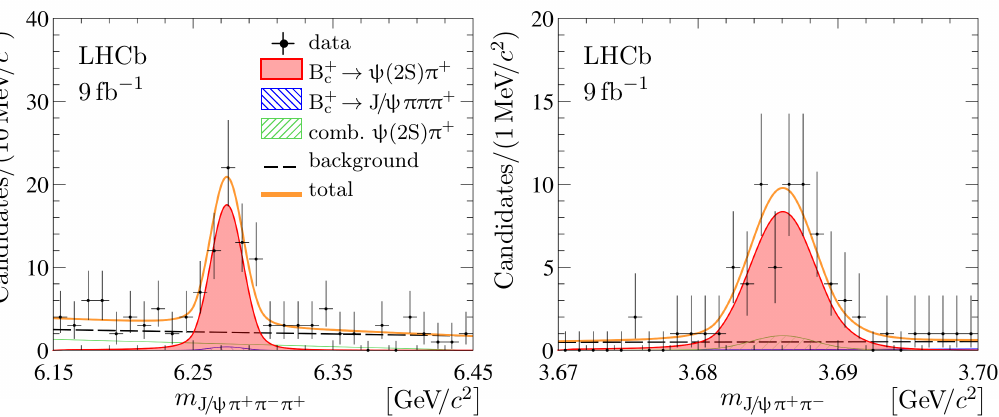
Figure 2 . Distributions of the (left) J / (cid:25) + (cid:25) − (cid:25) + and (right) J / (cid:25) + (cid:25) − masses for selected B + → ( (2S) → J / (cid:25) + (cid:25) − ) (cid:25) + candidates. Projections of a fit, described in the text, are over- c laid. The right plot corresponds to the mass range 6 . 24 < m